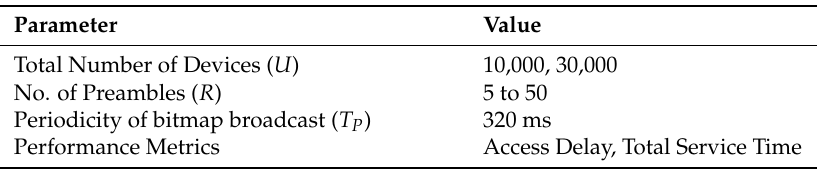
Table 1. Performance